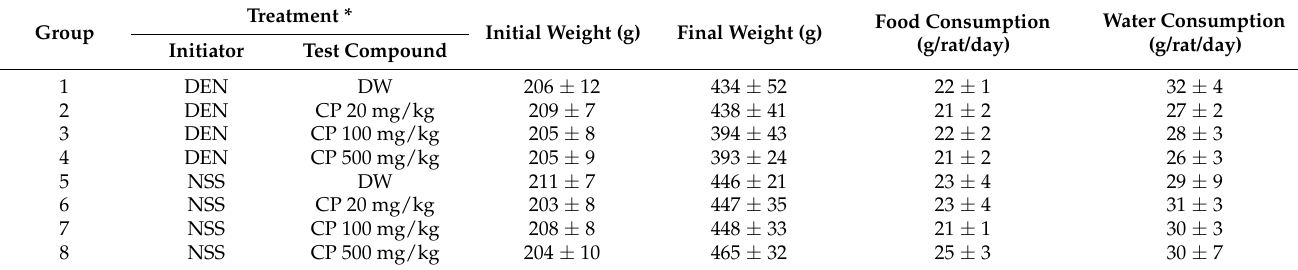
Table 1. Effect of CP on male Wistar rat body weight (BW) and food/water